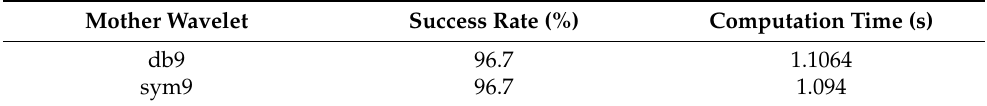
Table 3. Success rate for each mother wavelet using a linear SVM model. Mother Wavelet